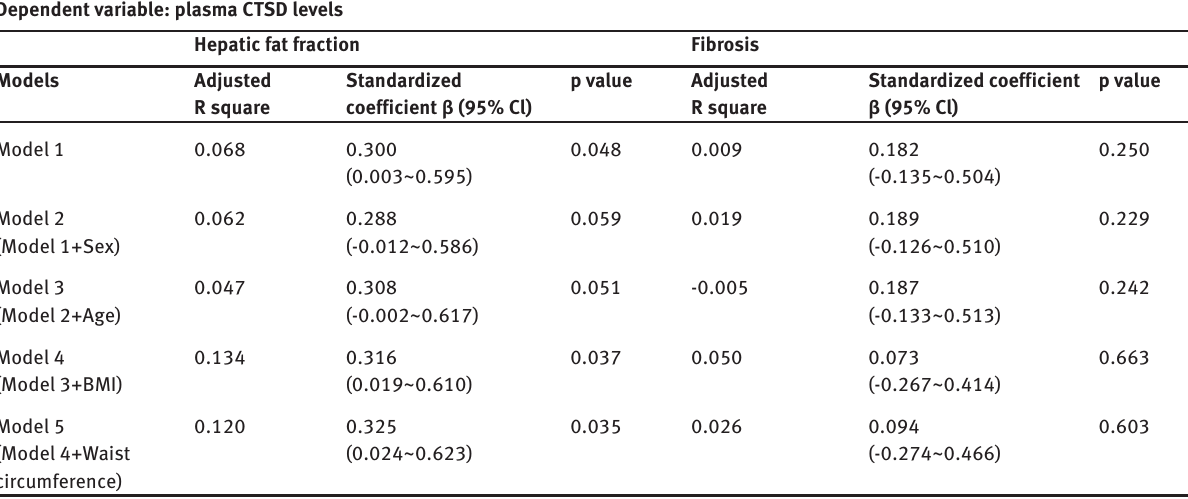
Table 2: Hepatic fat fraction (steatosis) is positively associated with plasma CTSD levels. Dependent variable: plasma CTSD levels